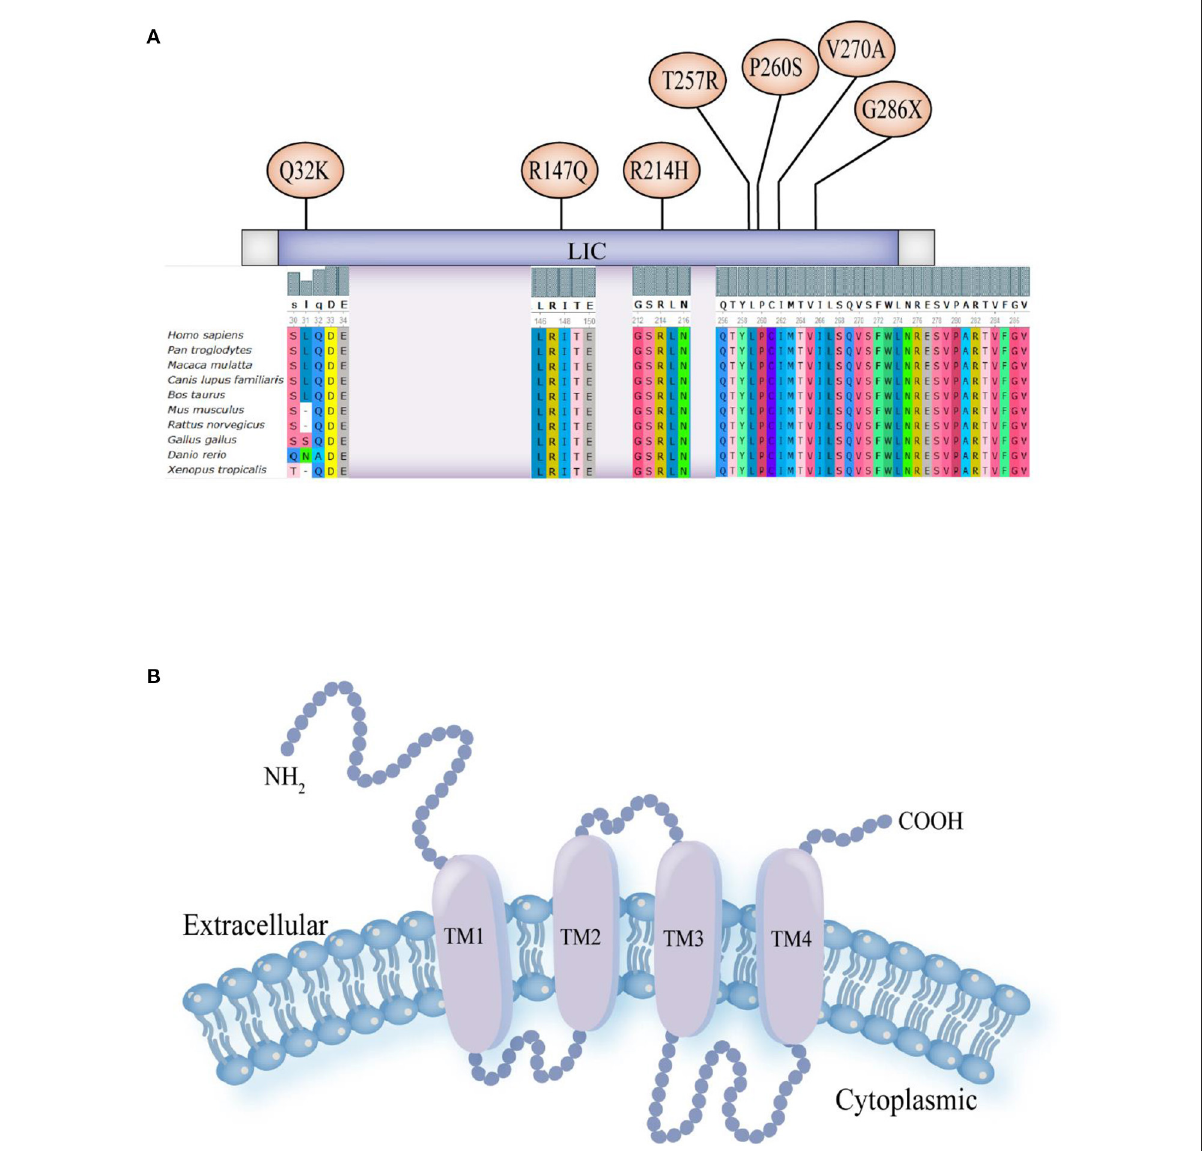
FIGURE1 (A) Schematic diagram of pathogenic variant sites in nucleic acids and the results of multiple sequence alignment analysis of eight patients: p. Gln32Lys (Q32K), p. Arg147Gln (R147Q), p. Arg214His (R214H), p. Thr257Arg (T257R), p. Pro260Ser (P260S), p. Val270Ala (V270A) and p. Gly286X (G286X). (B) Schematic model for the protein structure of GABA A R subunits. The extracellular domain N-terminus, followed by the transmembrane domain containing four transmembrane segments (helices TM1-4). There is a small extracellular loop between TM2 and TM3, a larger intracellular loop between TM3 and TM4, and the TM2 helices form the ion